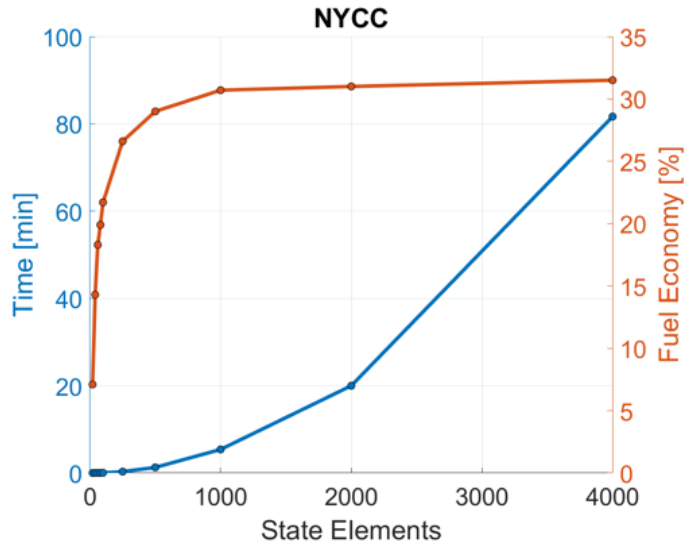
Figure 6. Influence of the number of the discrete state elements on the computational and fuel econ-